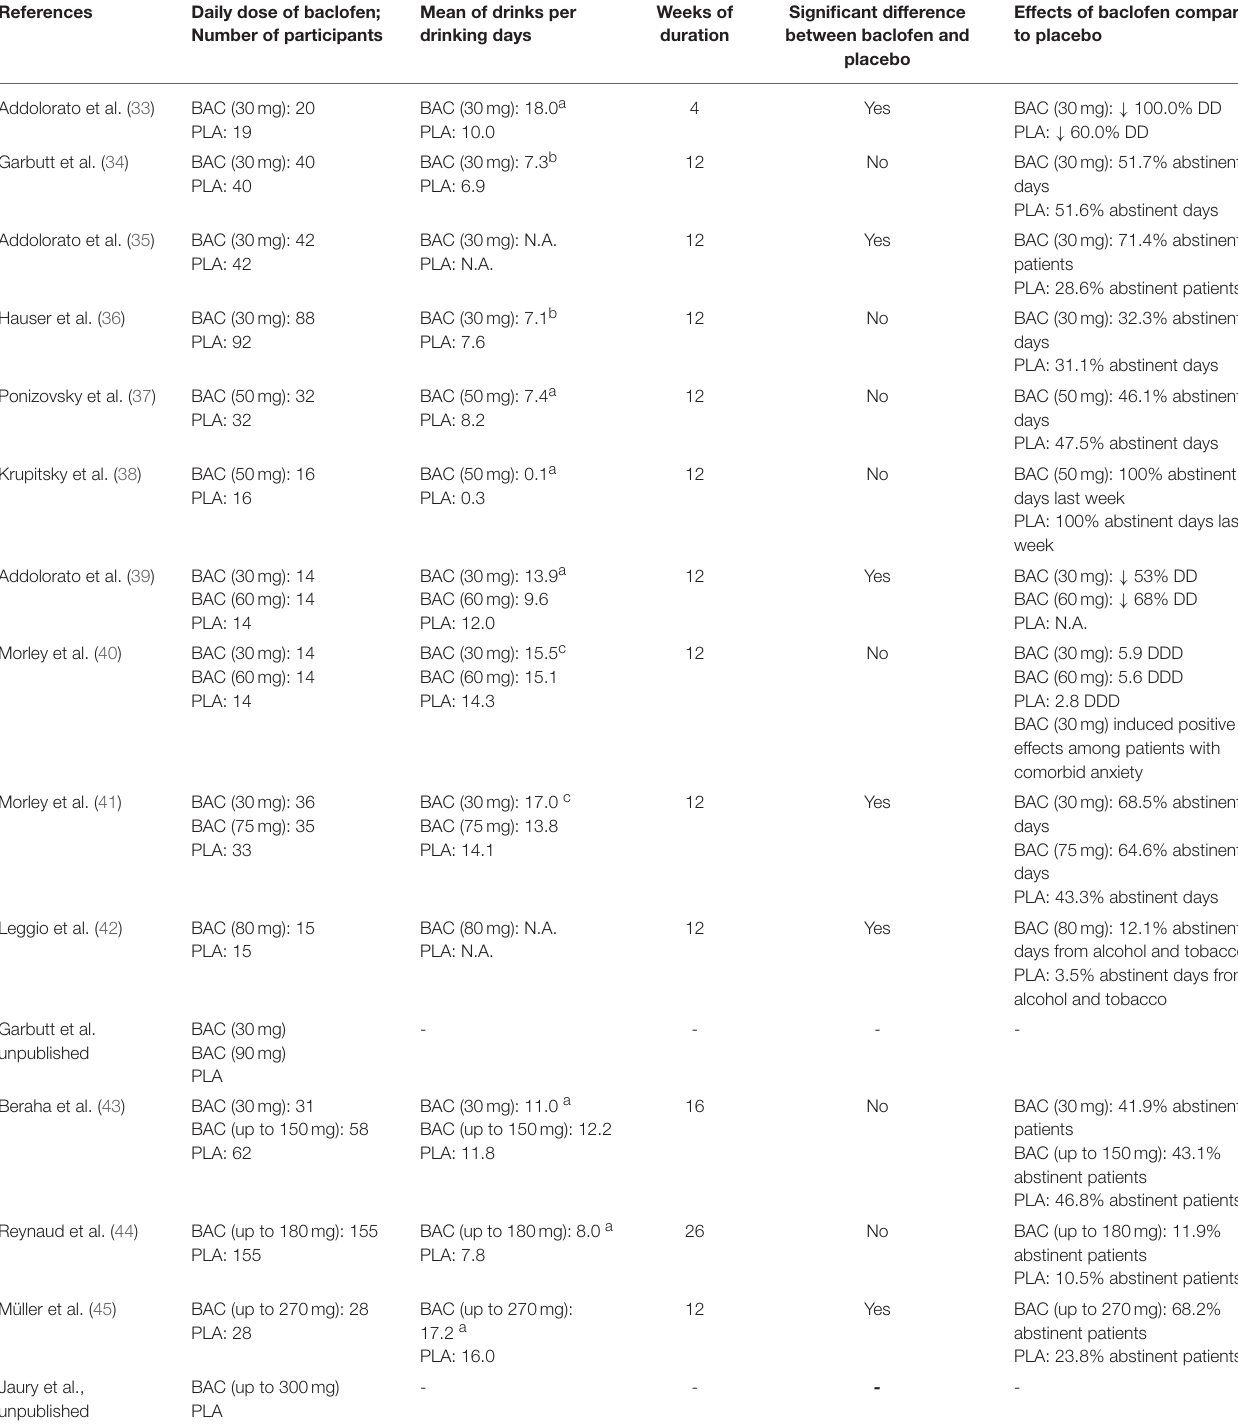
TABLE 1 | Randomized double-blind placebo-controlled trials.